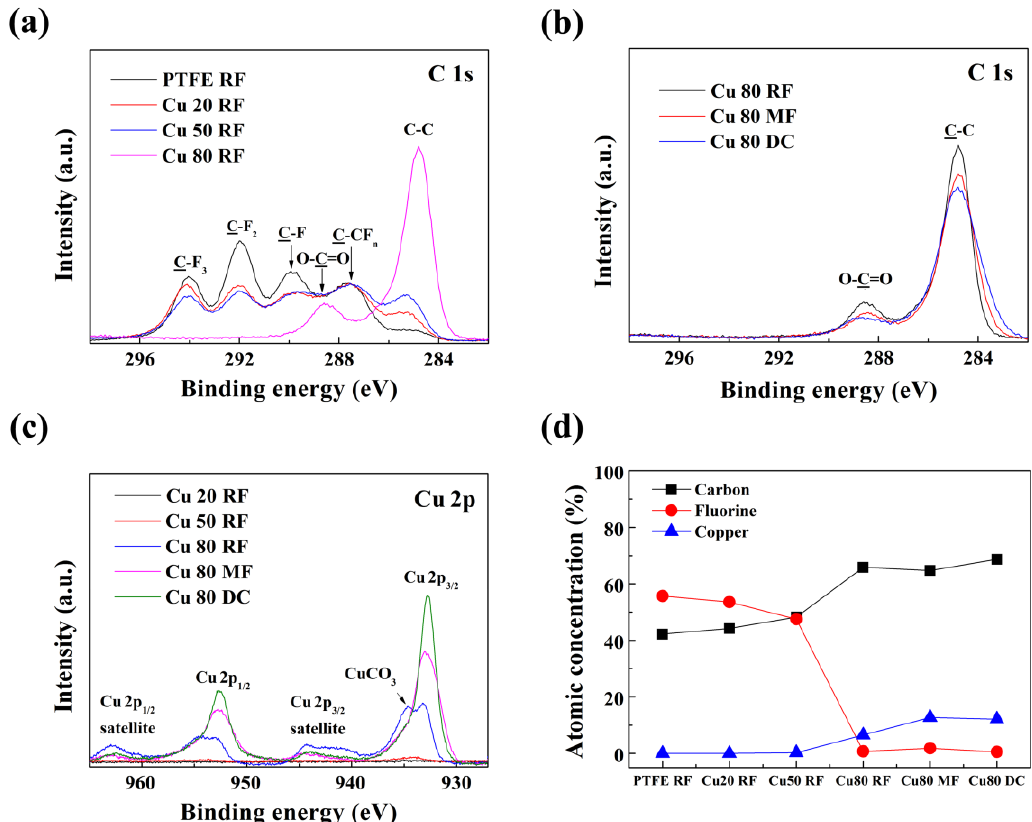
Figure 6. Normalized XPS spectra of ( a ) C 1s with increasing Cu content, ( b ) C 1s with RF, MF, and DC power sources, and ( c ) Cu 2p for the Cu/PPFC nanocomposite thin films with varying Cu contents and power sources. ( d ) Calculated carbon, fluorine, and copper ratio for the nanocomposite Cu/PPFC nanocomposite thin films.